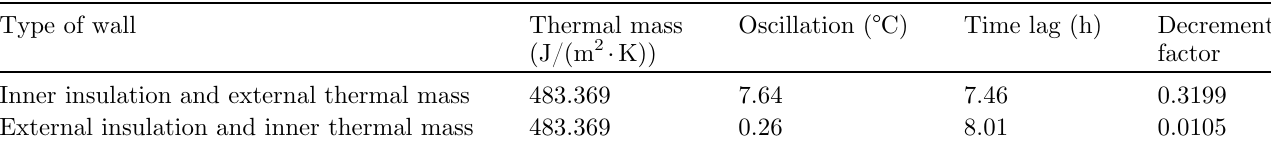
Table 4. Summary of the results obtained through the simulation of the two walls. Type of